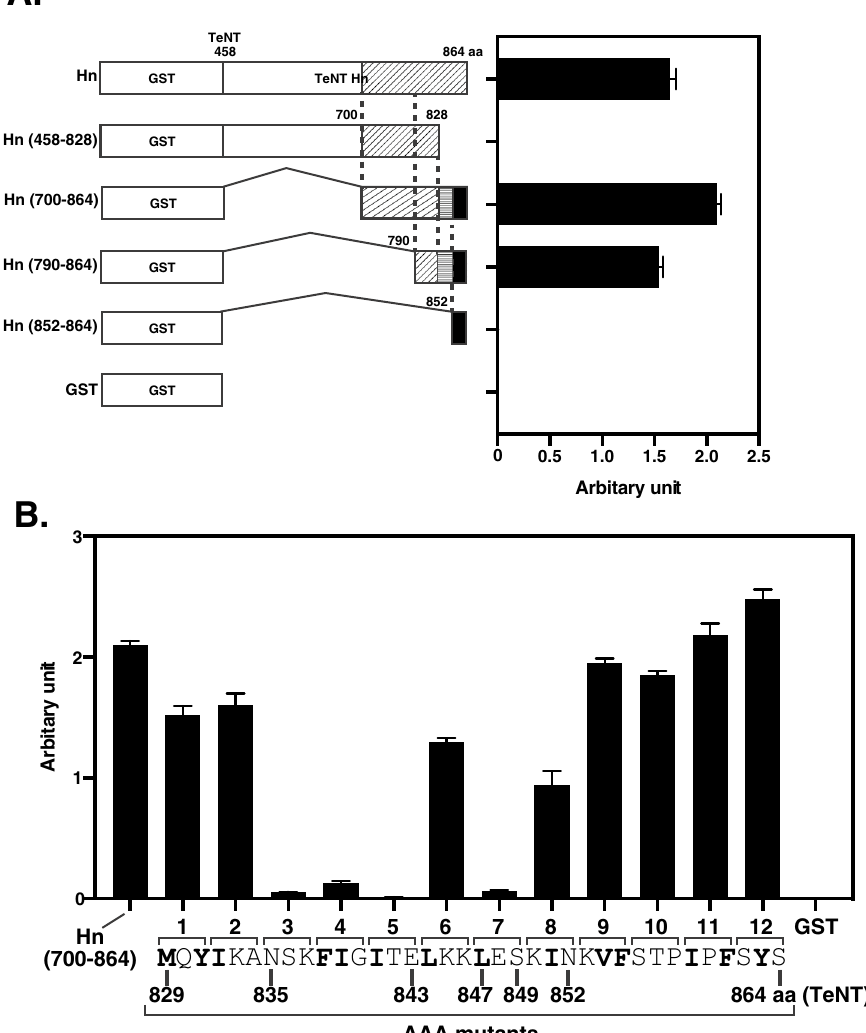
Figure 5. Epitope mapping of Hn-reactive 8D8. The reactivity of 8D8 to truncated Hn mutants ( A ) or Hn (700–864) mutants with triple alanine replacement ( B ) was analyzed by ELISA in quadruplicate. The amino acid sequence of Hn (829–864) is indicated and hydrophobic amino acids are shown in bold (B). The bar in each graph indicates the average. Error bars show the means ±